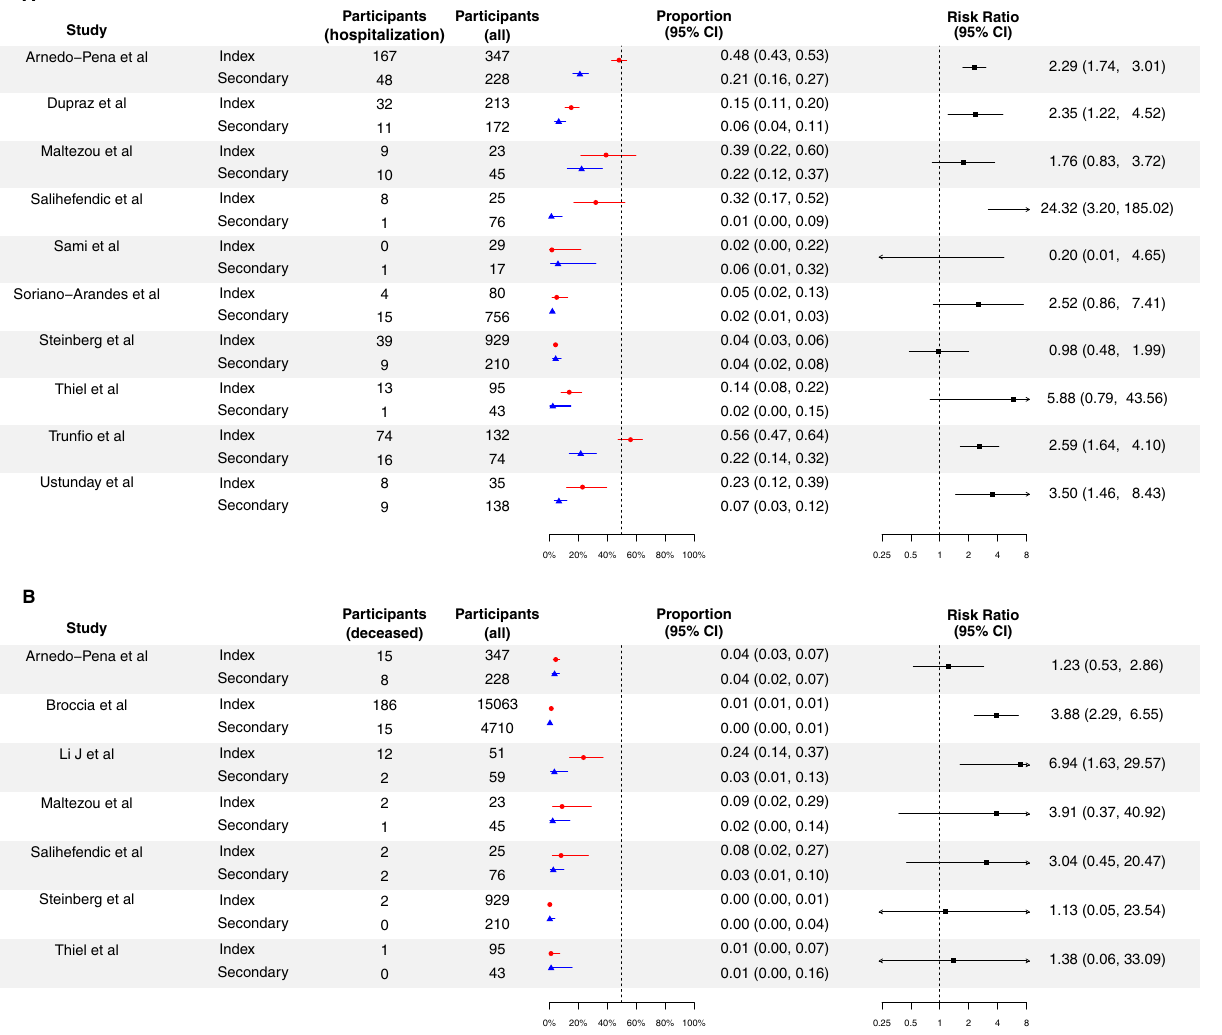
Fig. 5 Proportion of cases with hospitalization and death for the index cases and secondary cases for COVID-19, and their corresponding risk ratio of index cases, compared with secondary cases. Proportion of cases with hospitalization ( A ) and death ( B ) for the index cases and secondary cases for COVID-19, and their corresponding risk ratio of index cases, compared with secondary cases. Panel A and B indicate the proportion of hospitalization and death respectively. Red circles and lines indicate the proportion of fever of index cases and the corresponding 95% exact binomial con fi dence intervals. Blue triangles and lines indicate the proportion of fever of secondary cases and the corresponding 95% con fi dence intervals. Black squares and lines indicate the risk ratio of proportion of fever of index cases compared with secondary cases and the corresponding 95% con fi dence intervals calculated based on normal approximation. All statistical tests are two-sided tests. Adjustments are not made for multiple